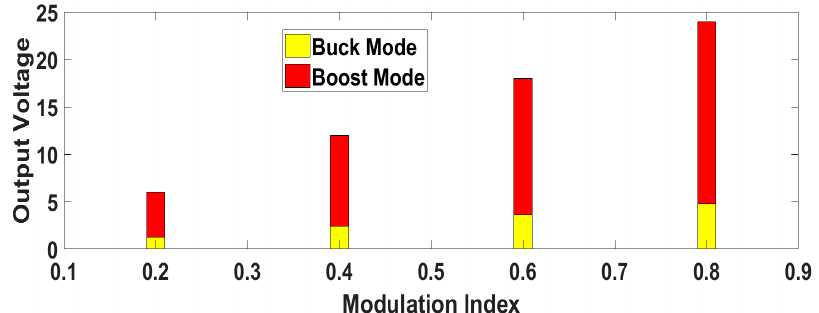
Figure 23. Experimental DC–AC inverter output voltage comparisons of buck mode and boost mode with a boost factor of 4.